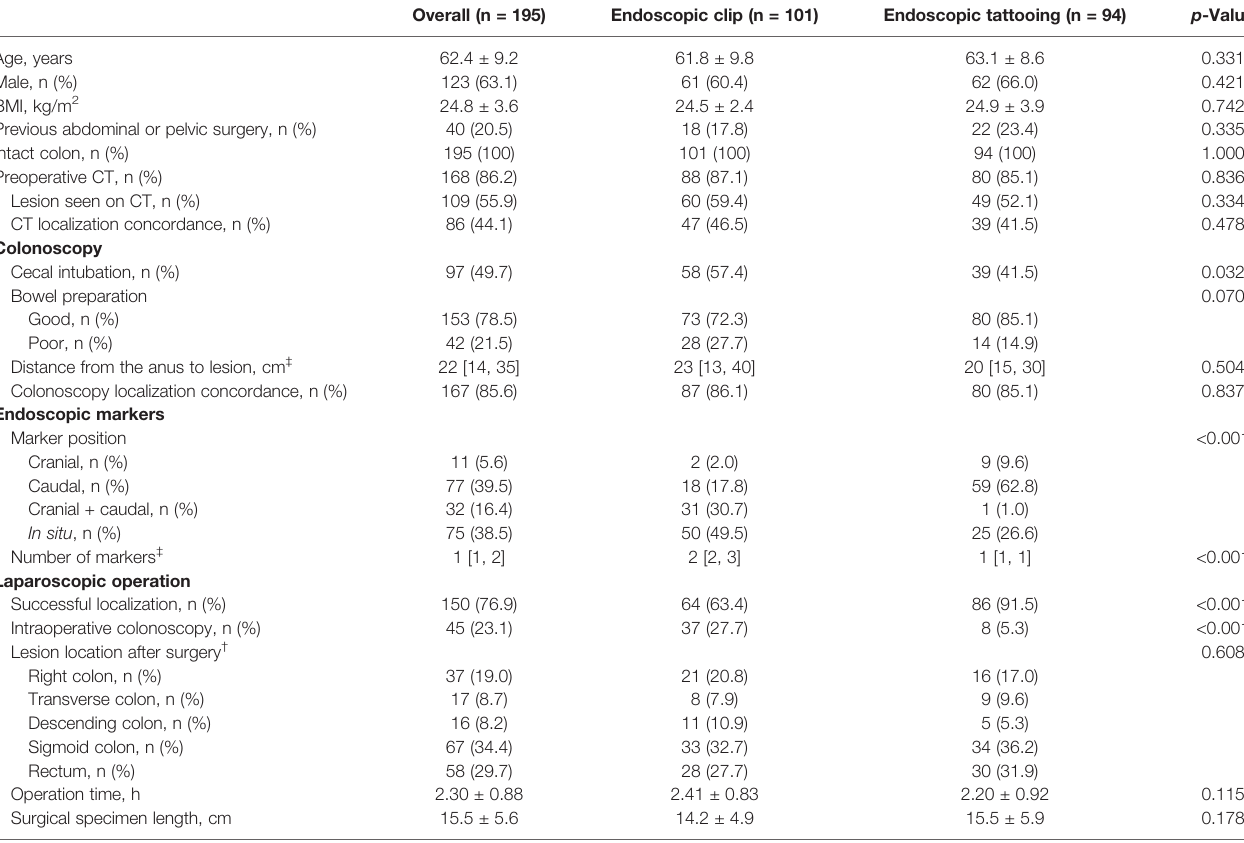
TABLE 1 | The demographic and clinical characteristics of the study patients in the endoscopic clip and tattooing